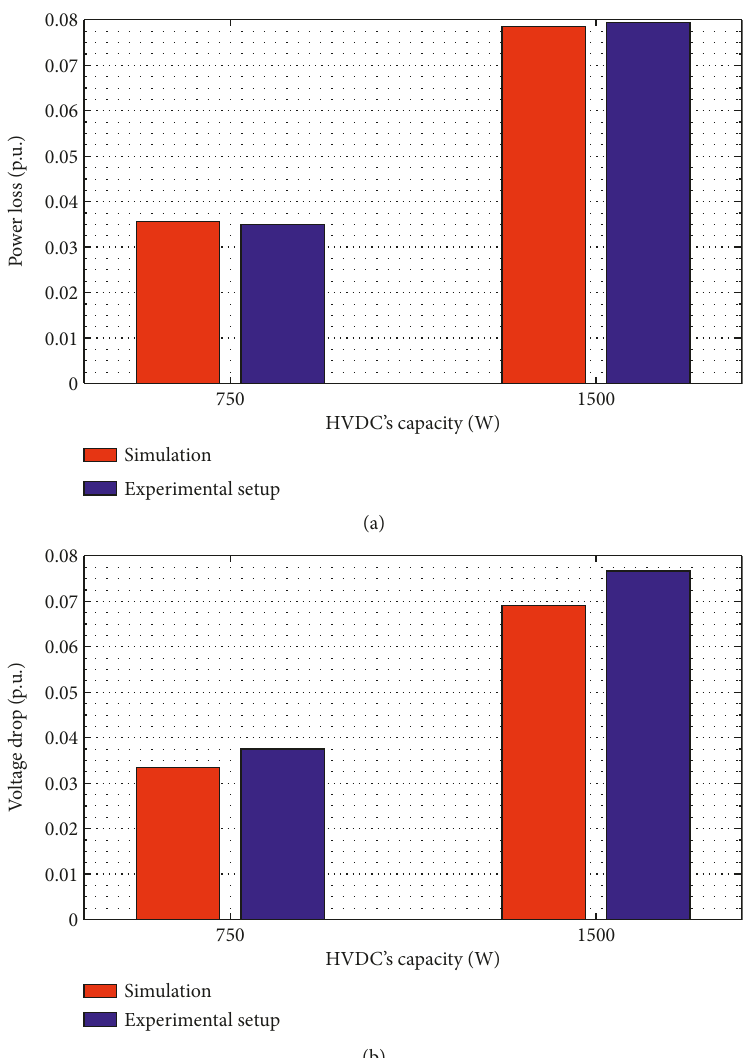
Figure 17: Comparison of the power losses and voltage drops based on the electrical load conditions. (a) Comparison of the power losses and (b) comparison of the voltage